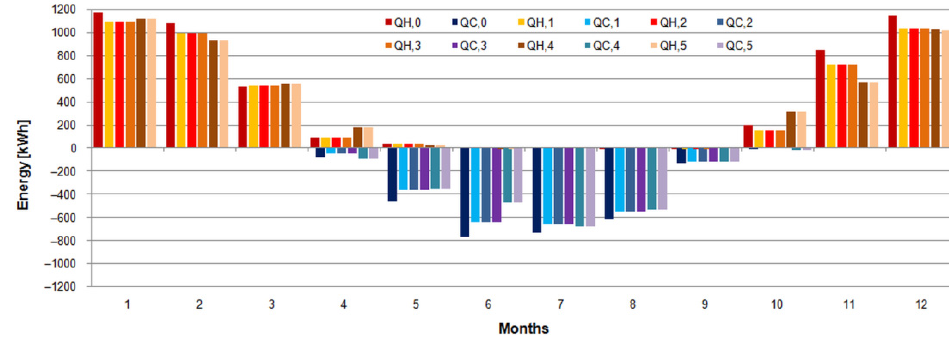
Figure 17. Monthly energy use for space heating and cooling of the building.